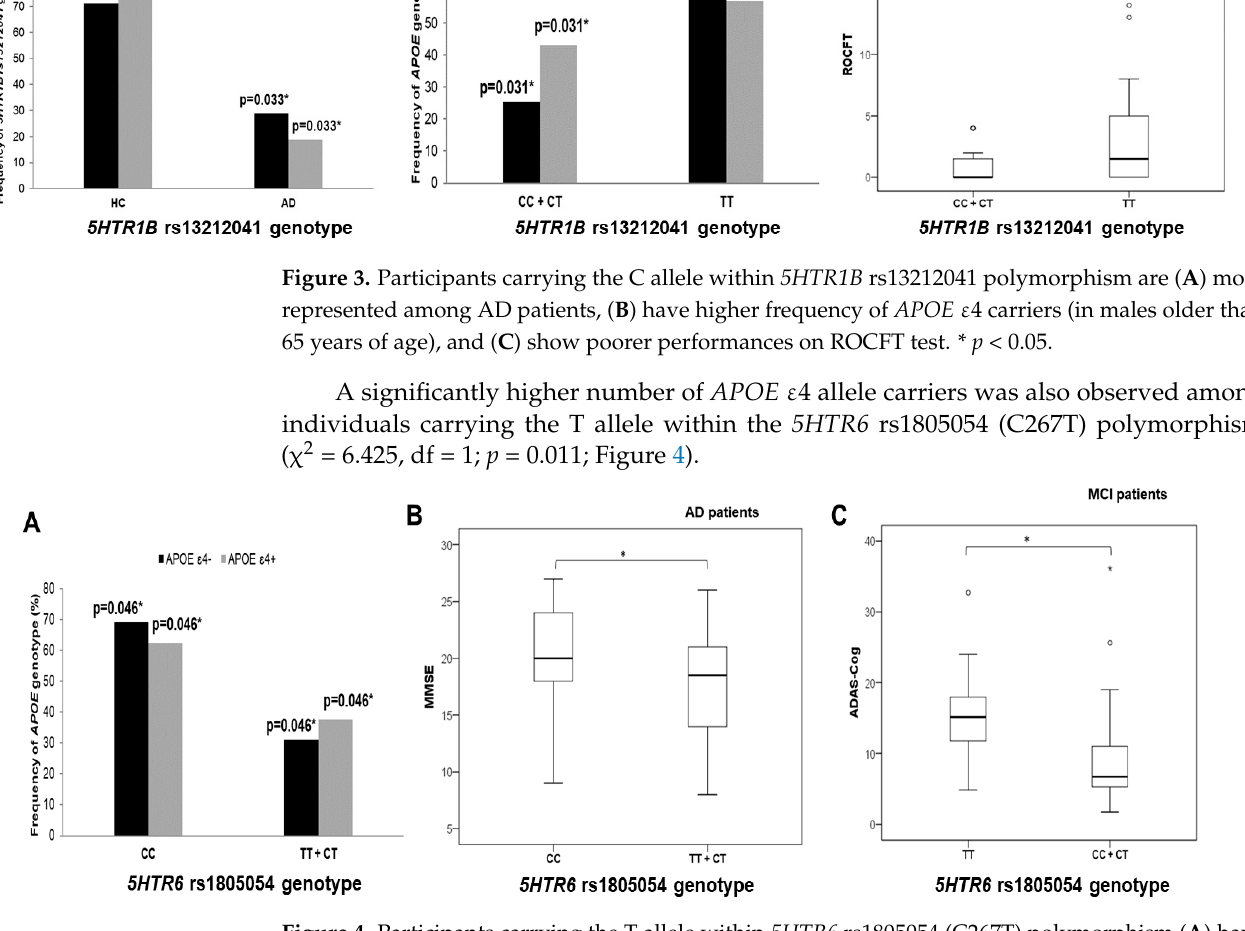
Figure 4. Participants carrying the T allele within 5HTR6 rs1805054 (C267T) polymorphism ( A ) have higher frequency of APOE ɛ 4 carriers (in individuals younger than 65 years of age), ( B ) have poorer performances on MMSE (shown in AD patients), and ( C ) have poorer performances on ADAS–Cog (shown in MCI patients). * p < 0.05.